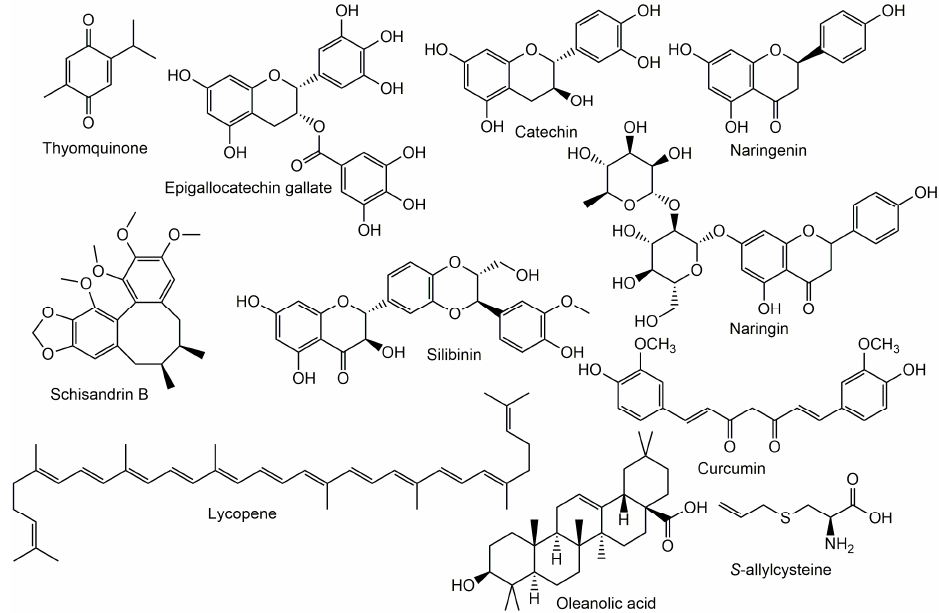
Figure 3. Chemical structures of natural metabolites tested for reno-protective potential.